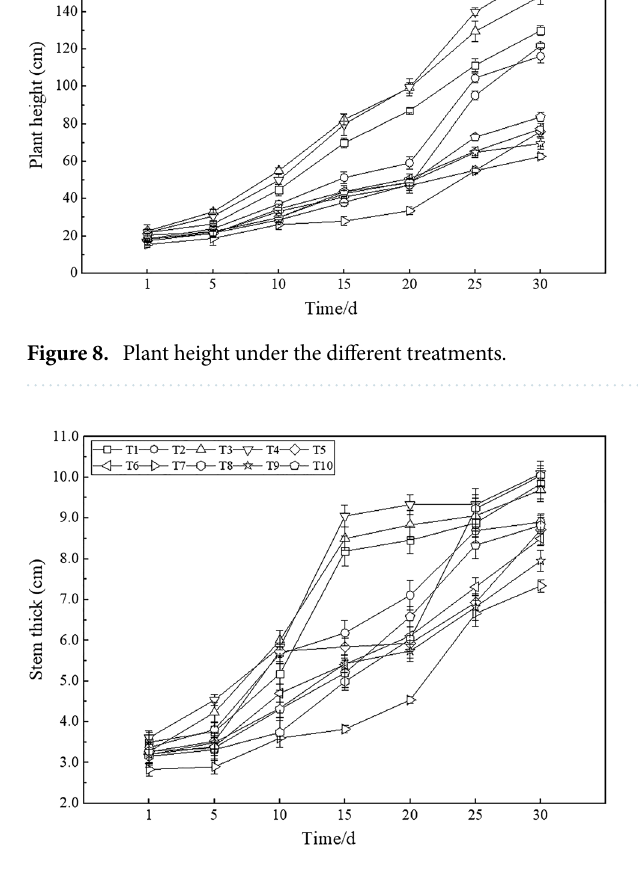
Figure 9. Stem thickness under the different